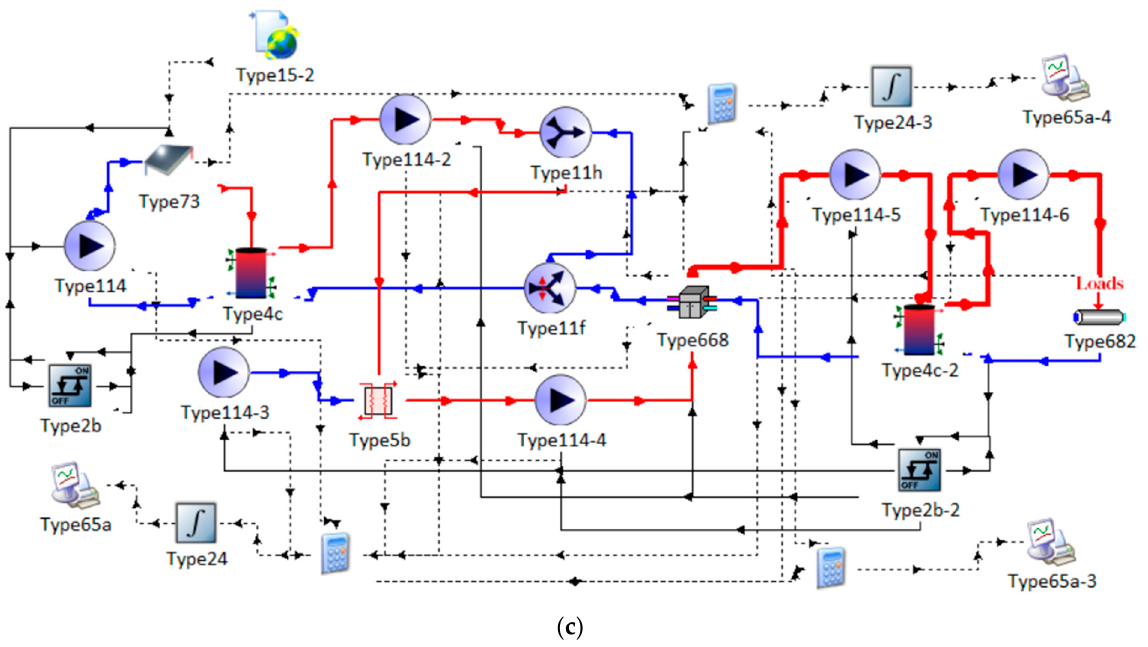
Figure 5. ( a ) The pure serial dual-source heat pump operating mode; ( b ) the ice melting serial dual-source heat pump operating mode; ( c ) the affected serial dual-source heat pump operating mode.